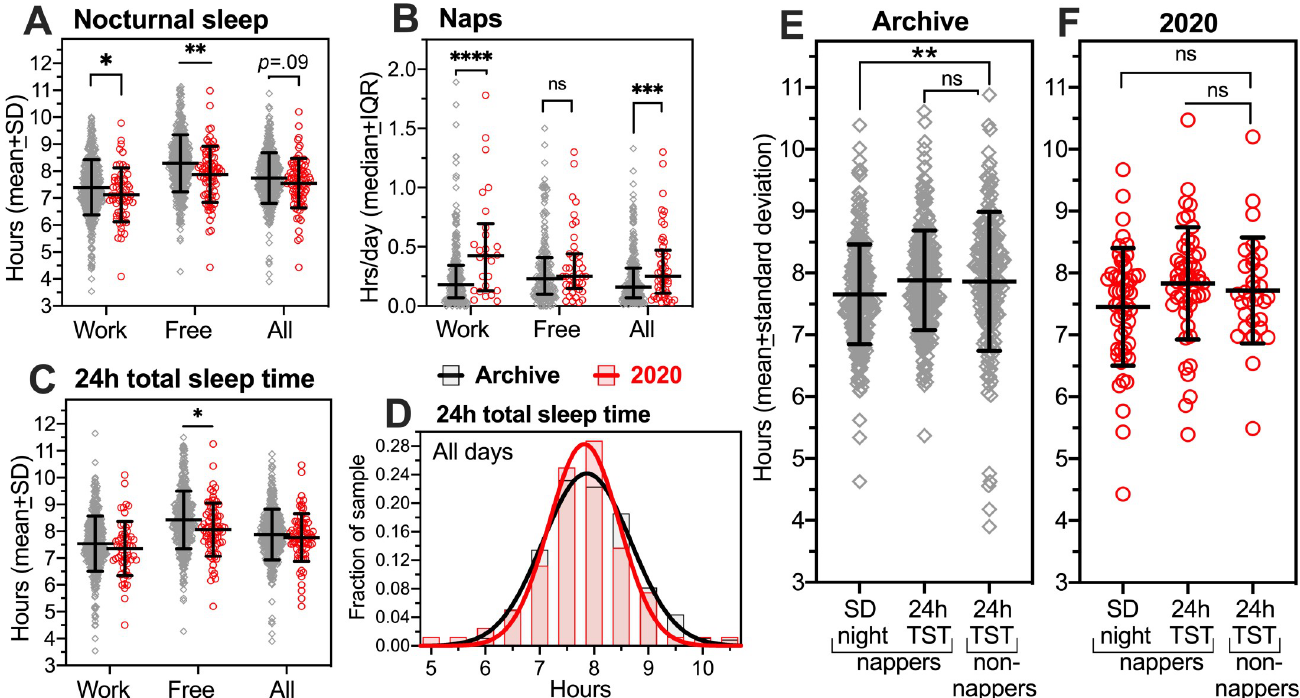
Fig 3. Nocturnal, daytime and 24h total sleep duration in archive (grey) and 2020 (red) groups. [A]. Group mean ( ± standard deviation) hours of sleep at night prior to work, free and all days (corrected for self-reported sleep latency and wake-after-sleep-onset). [B]. Group mean hours of daytime nap sleep. [C]. Group mean total daily sleep (sum of nocturnal sleep and daytime naps). [D]. Frequency distributions with gaussian curve fits of 24 h total daily sleep duration in the archive group (black curve) and the 2020 group (red curve). [E,F]. Nocturnal and 24h total sleep duration in nappers and non-nappers in the archive group (E) and the 2020 group (F). Panels A,C: (work x free days) ANOVA with Sidak multiple comparisons tests. Panel B: Mann-Whitney U test. Panels A (all days), B (all days), E,F: Unpaired t-tests. � p < .05, �� p < .01, ���� p < .0001.